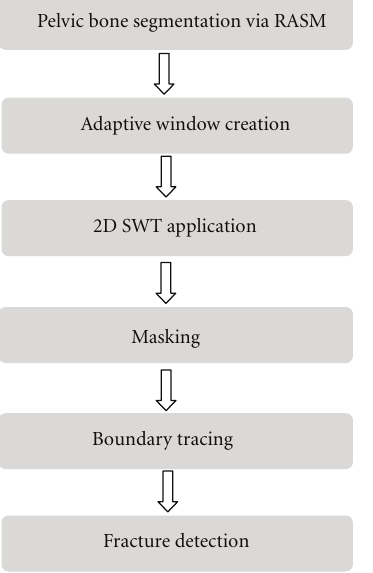
Figure 1: Schematic diagram of pelvic bone fracture detection.